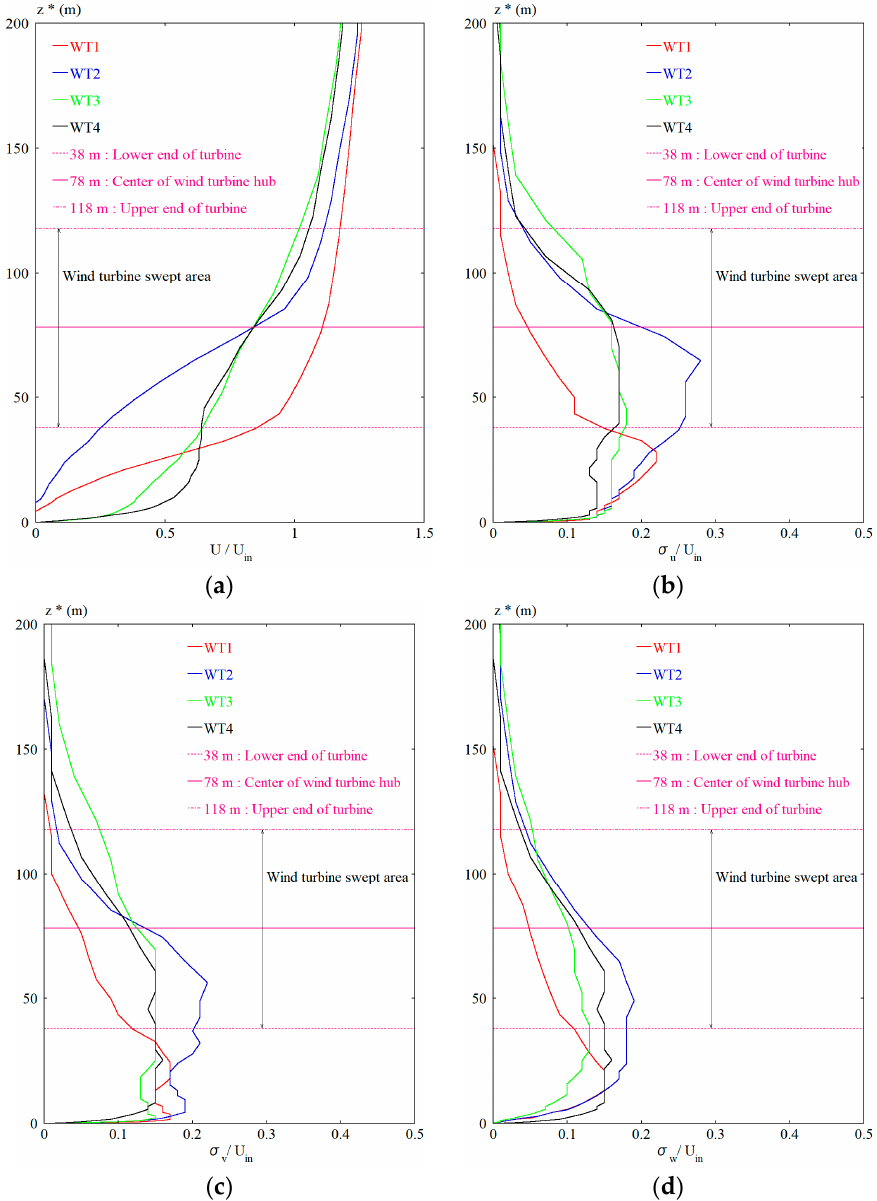
Figure 13. Vertical profiles of various physical quantities at the wind turbine locations. ( a ) Profiles of mean streamwise wind velocity. ( b ) Standard deviation of the streamwise wind velocity. ( c ) Standard deviation of the spanwise wind velocity ( d ) Standard deviation of the vertical wind velocity.